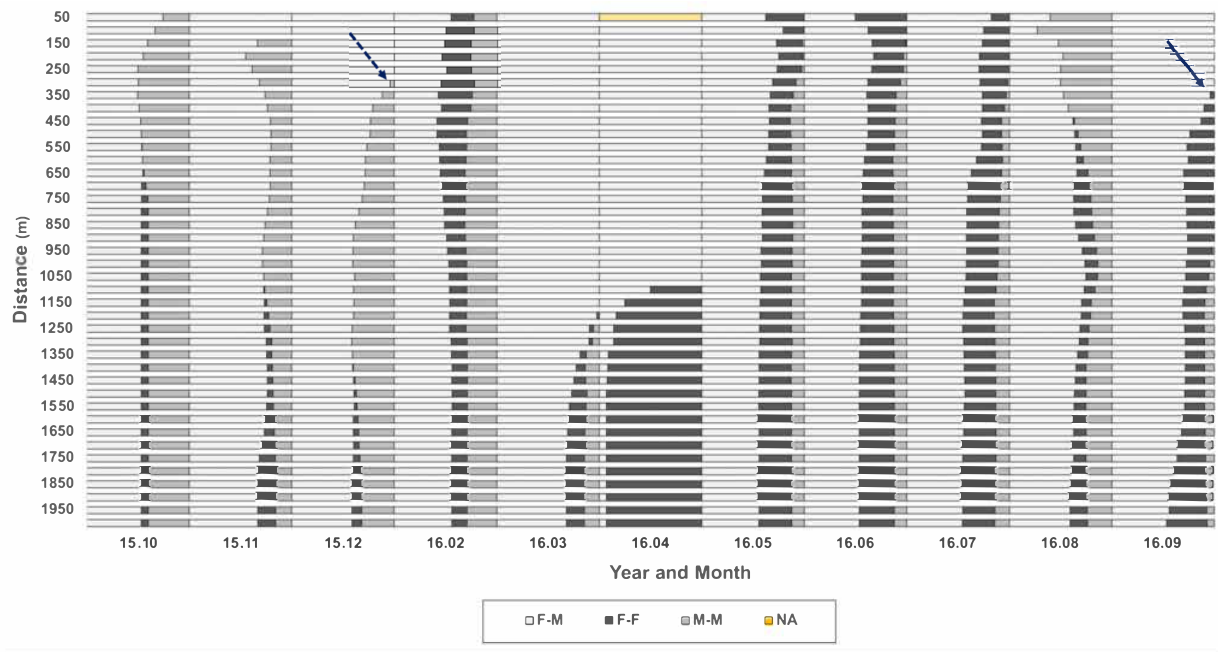
Figure 7. Relative frequencies of co-occurrence of same and different sex individuals across distances from 50 m to 2000 m in the Macdo wetland during the survey period (October 2015–September